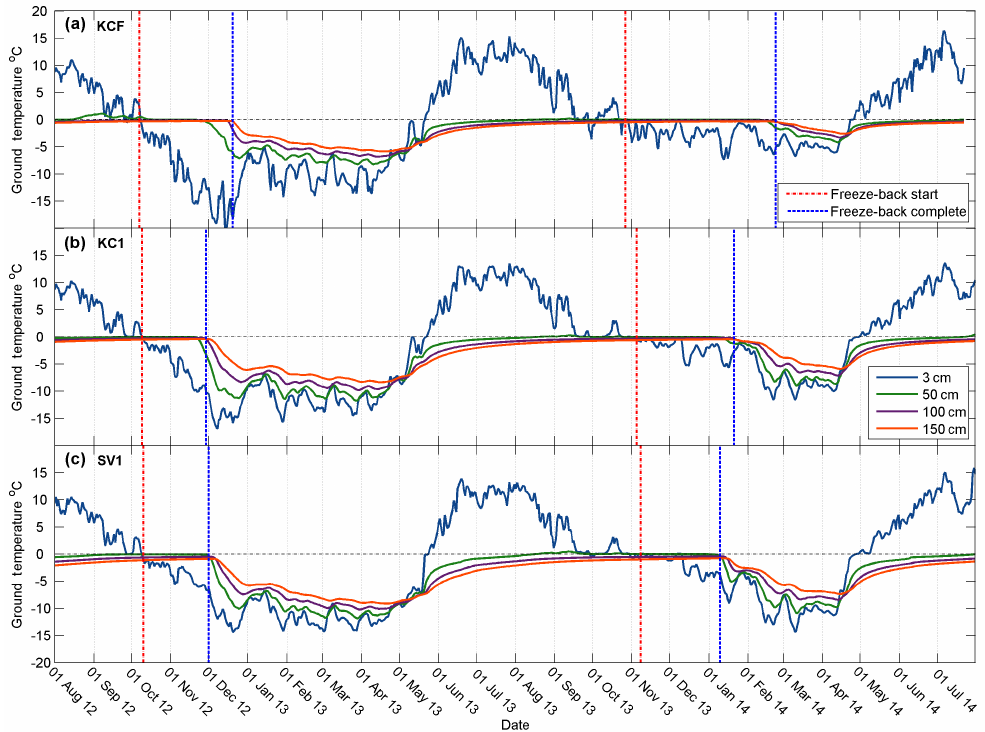
Figure 5. Daily average temperatures at four depths from 2 years (August 2012 to July 2014) is shown for three sites ( a : KCF, b : KC1, and c : SV1). The start (red) and end (blue) of the freeze-back periods are